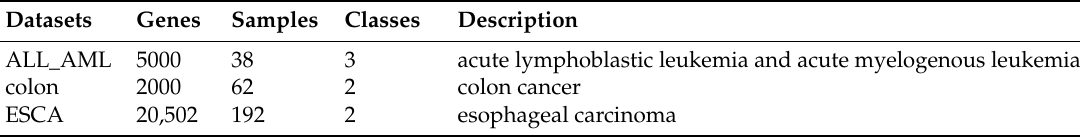
Table 1. Details of the three